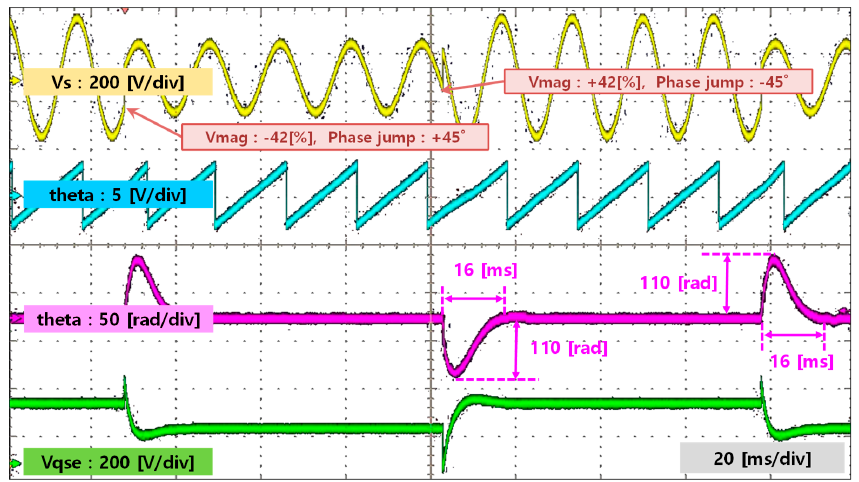
Figure 18. PLL response characteristics for changing the simulated system voltage.